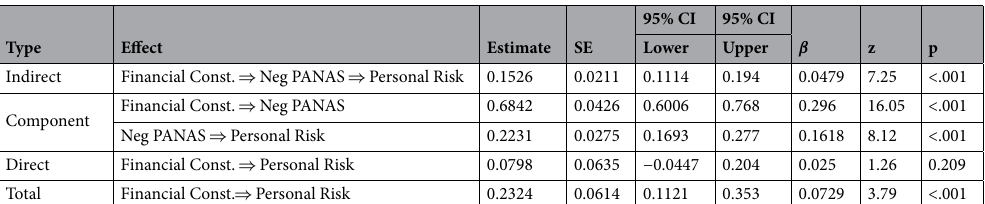
Table 3. Indirect and total effects for personal risk mediation model. Confidence intervals computed with method: Standard (Delta method). Betas are completely standardized effect sizes.